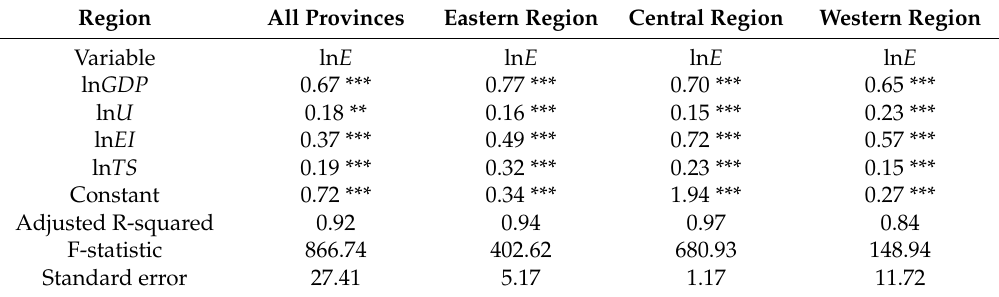
Table 4. Panel estimation results (1996–2005).